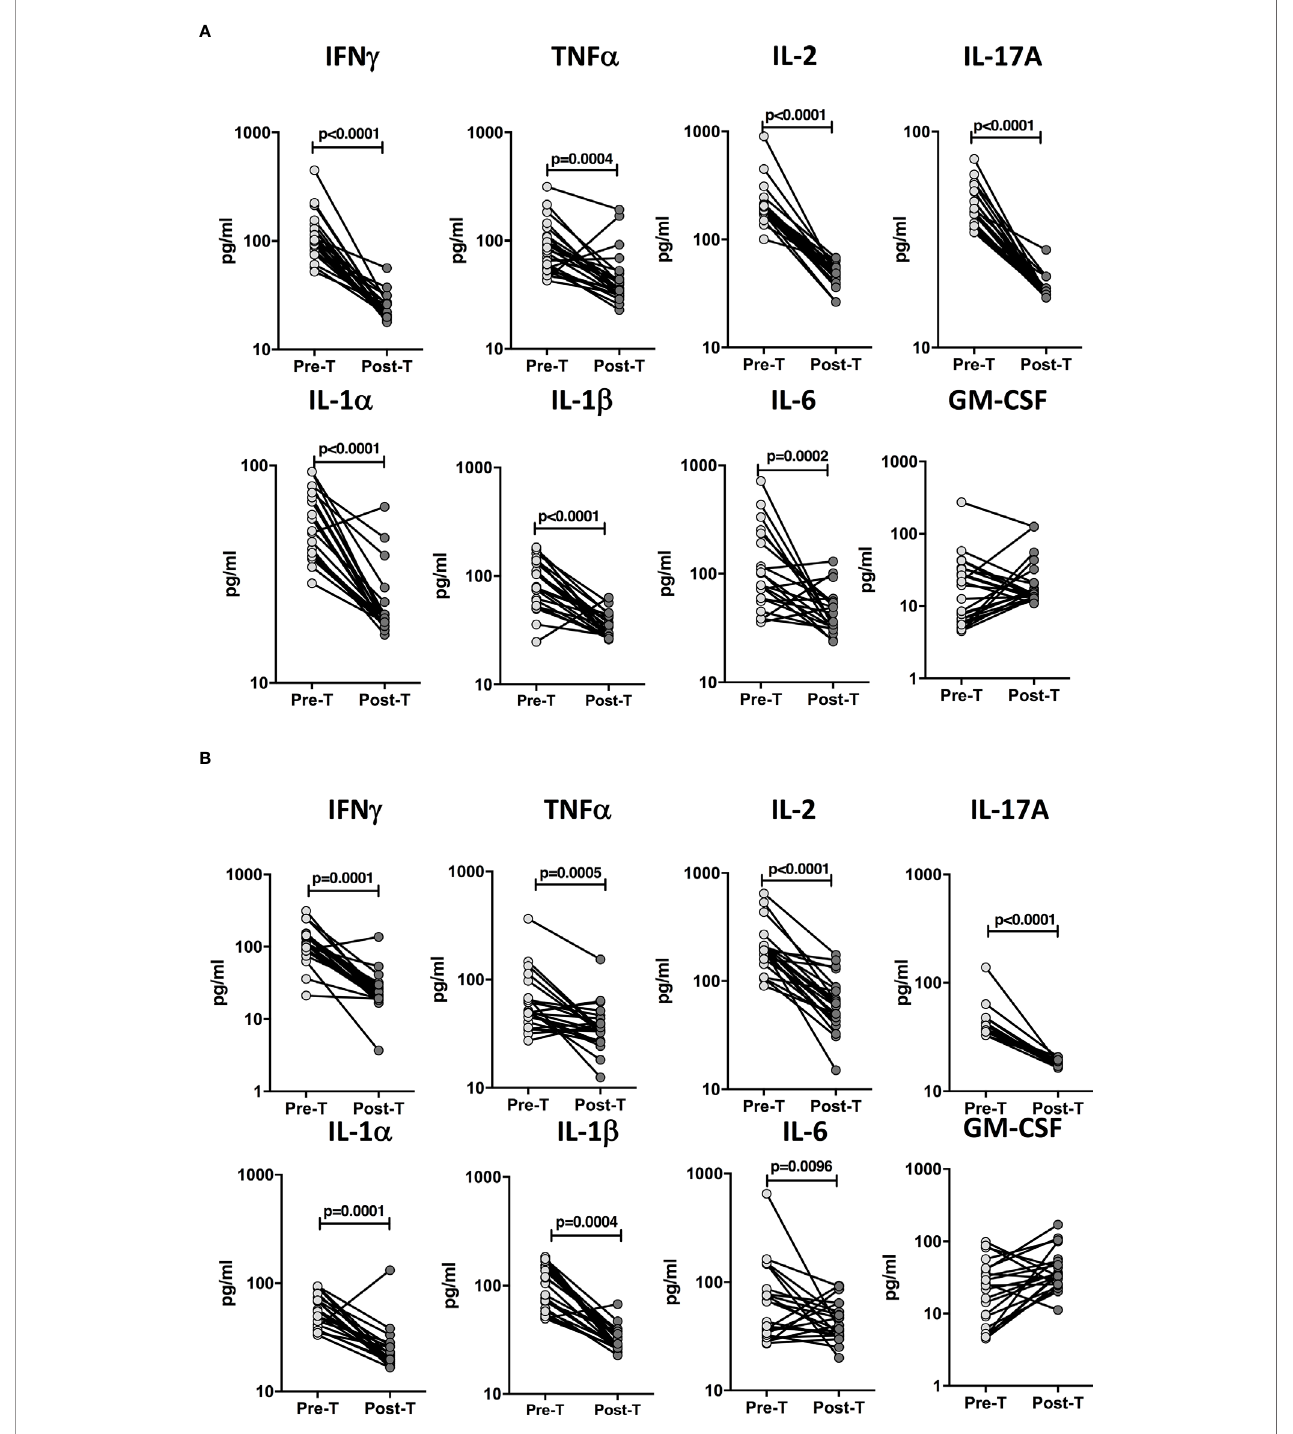
FIGURE 5 | Diminished plasma levels of Type 1, Type 17, and proin fl ammatory cytokines at the end of standard anti-tuberculosis (TB) therapy in children with con fi rmed and uncon fi rmed TB disease. The plasma levels of type 1, type 17, and other proin fl ammatory cytokines at baseline (pre-T) and at 6 months of anti-TB treatment (post-T) in a subset of (A) Con fi rmed TB (n=24) and (B) Uncon fi rmed TB (n=23) children. The data are presented as line graphs with each line representing a single